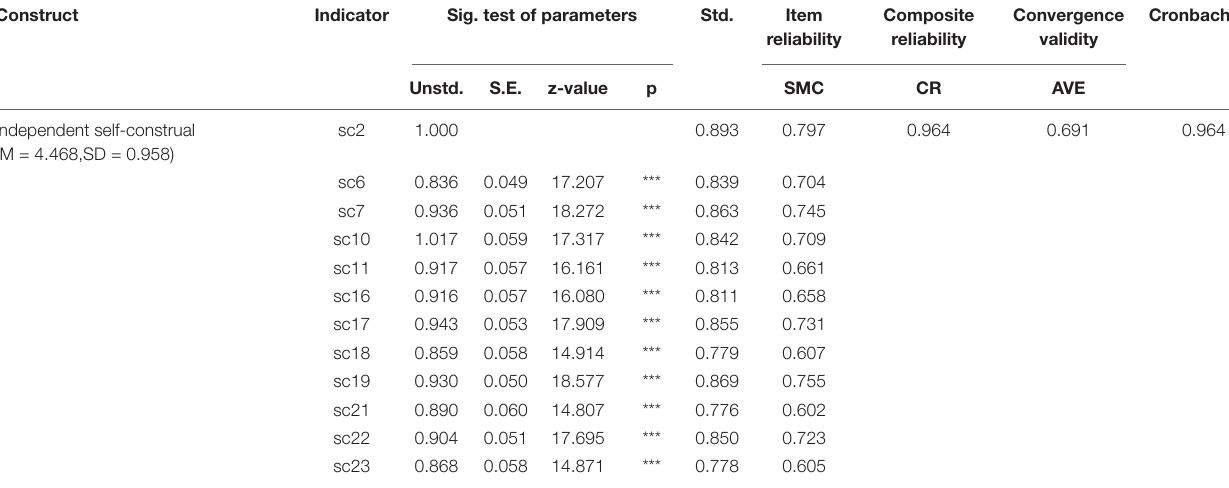
TABLE 3 | Reliability and convergent validity of independent self-construal scale ( n = 210). Construct Indicator Sig. test of parameters